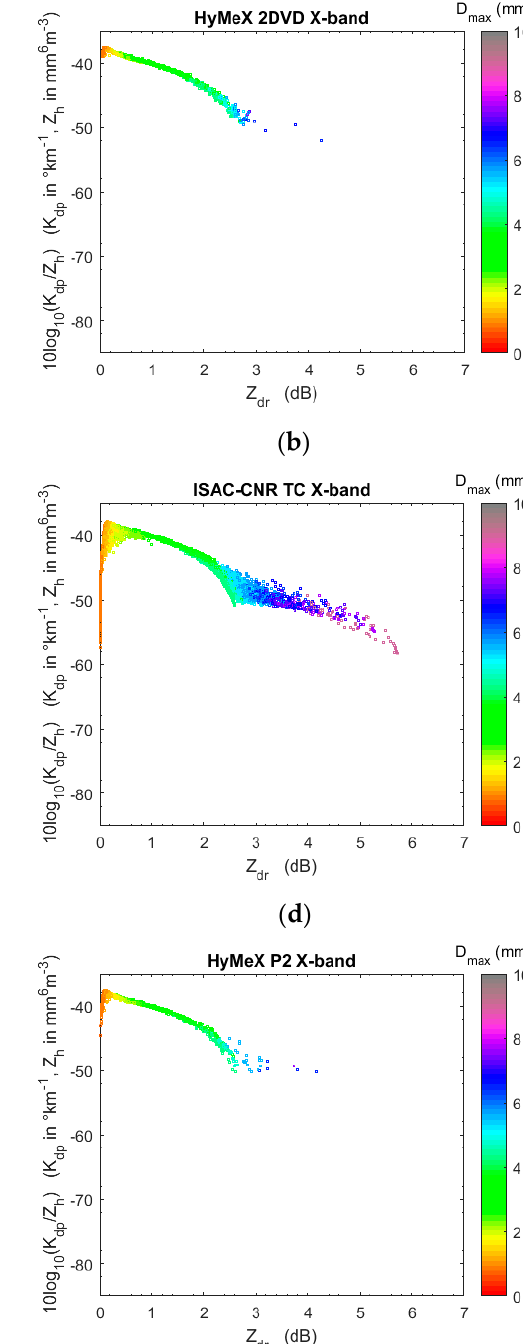
Figure 3. As for Figure 2, but for C-band. ( a ) IFloodS 2DVD dataset; ( b ) HyMeX 2DVD dataset; ( c )